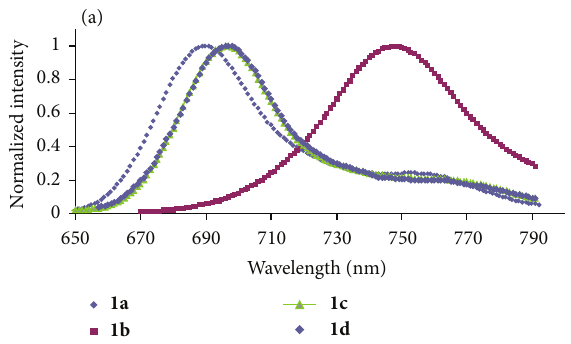
Figure 3: The emission peaks of the complexes ( 1a–1d ) (a).